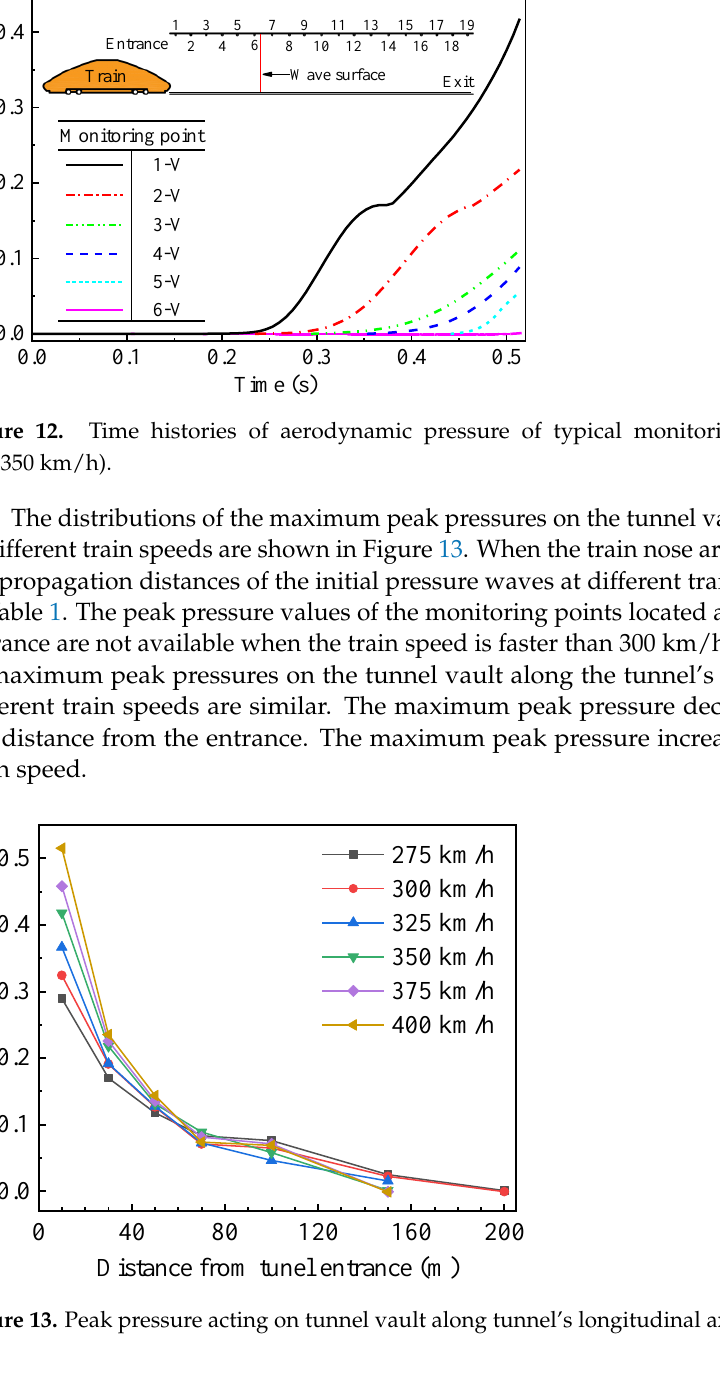
Figure 13. Peak pressure acting on tunnel vault along tunnel’s longitudinal axis in Stage I.